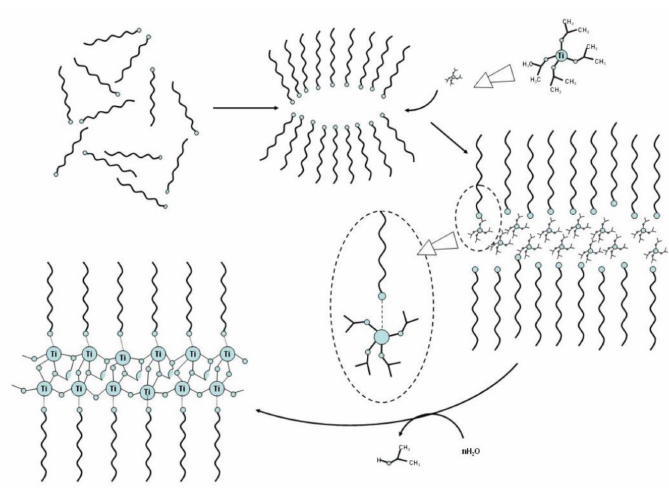
Figure 3a,b exemplify SEM micrographs and XRD diffractograms, respectively,